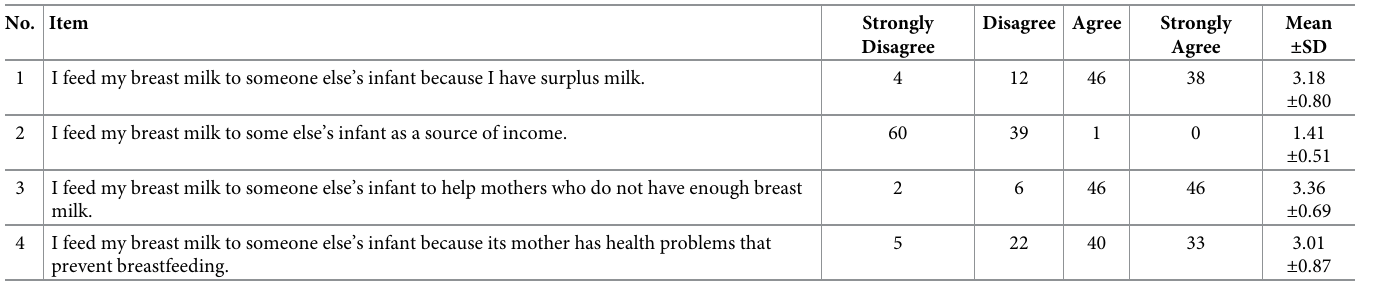
Table 3. Motivating factors that influence milk mothers to breastfeed. No. Item